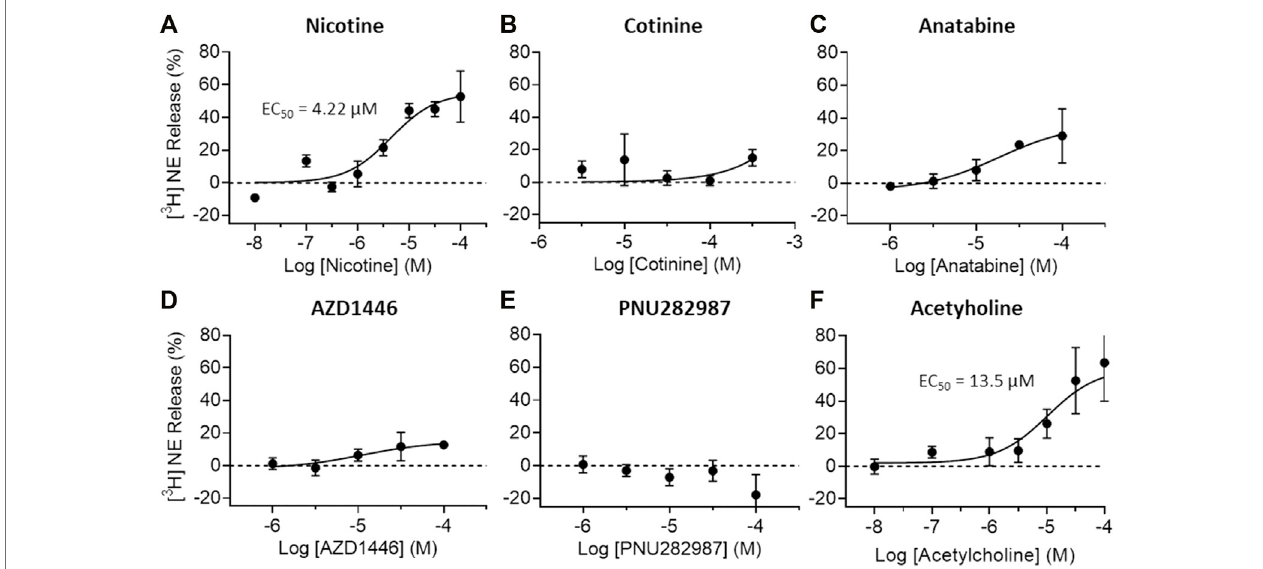
FIGURE 5 | Effects of nAChR ligands on in vitro norepinephrine release. Norepinephrine (NE) release from crude hippocampal synaptosome preparations were measured after (A) nicotine (B) cotinine, (C) anatabine, (D) AZD1446, (E) PNU282987, and (F) acetylcholine treatment. Only nicotine and acetylcholine seem to elicit clear NE release at the concentrations tested. Data are presented as mean ± S.D.